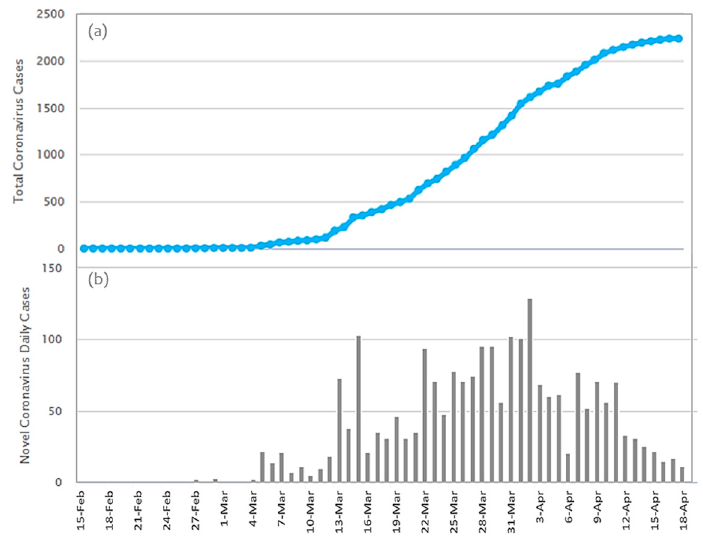
Figure 1. The time-series of the COVID-19 infection curve in Greece for the period 15 February 2020 to 18 April 2020. The first infection emerged on 26 February 2020 (and was recorded on 27 February 2020; data source [15]). ( a ) Total Coronavirus Cases; ( b ) Novel Coronavirus Dairy Cases.